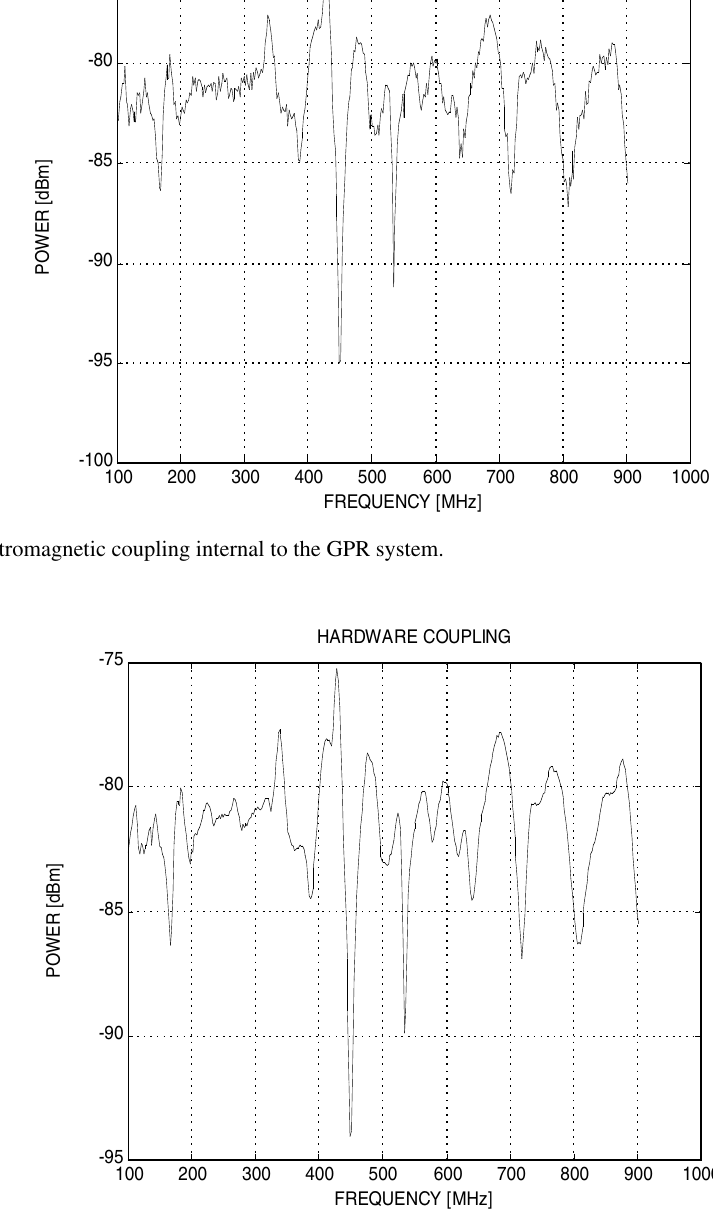
Fig. 7. Result of an averaging performed on the electromagnetic